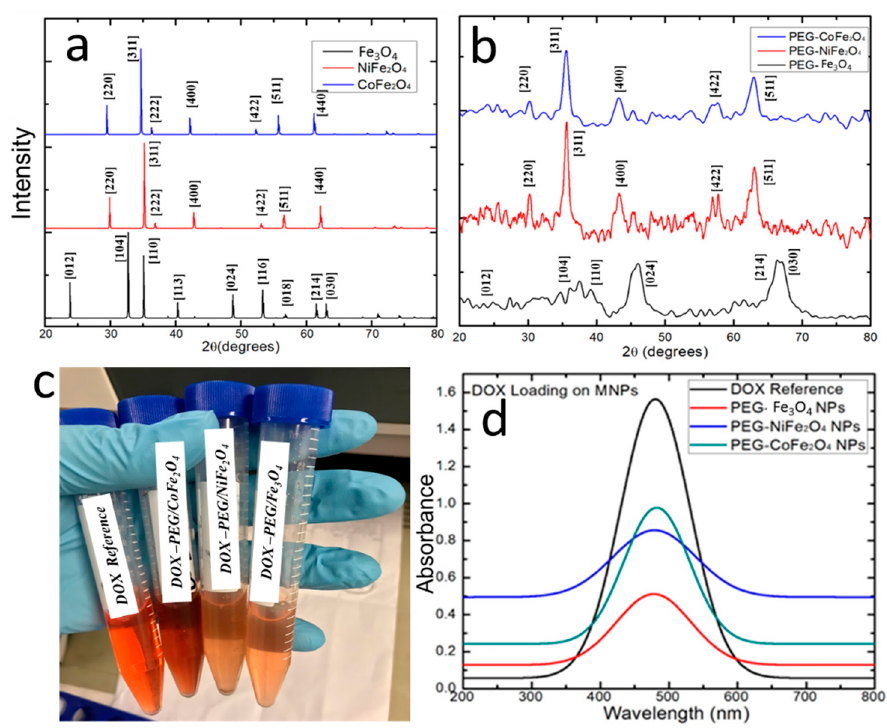
Figure 2. X-ray diffraction patterns of ( a ) pristine magnetic nanoparticles (MNPs) and ( b ) polyethylene glycol (PEG)-coated MNPs (Fe 3 O 4 , NiFe 2 O 4 and COFe 2 O 4 ), ( c ) doxorubicin (DOX) loaded-PEG coated magnetic nanofluid, ( d ) UV-visible absorption spectra of DOX loaded PEG-coated magnetic nanofluids (MNFs).